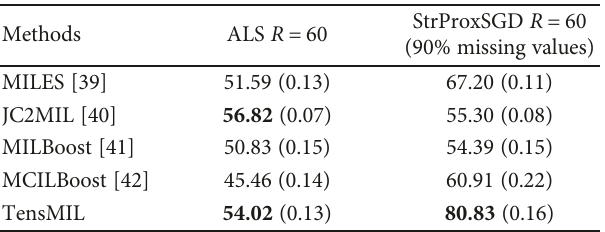
Table 4: Test accuracy from full and 90% missing values for the 2 class problem.